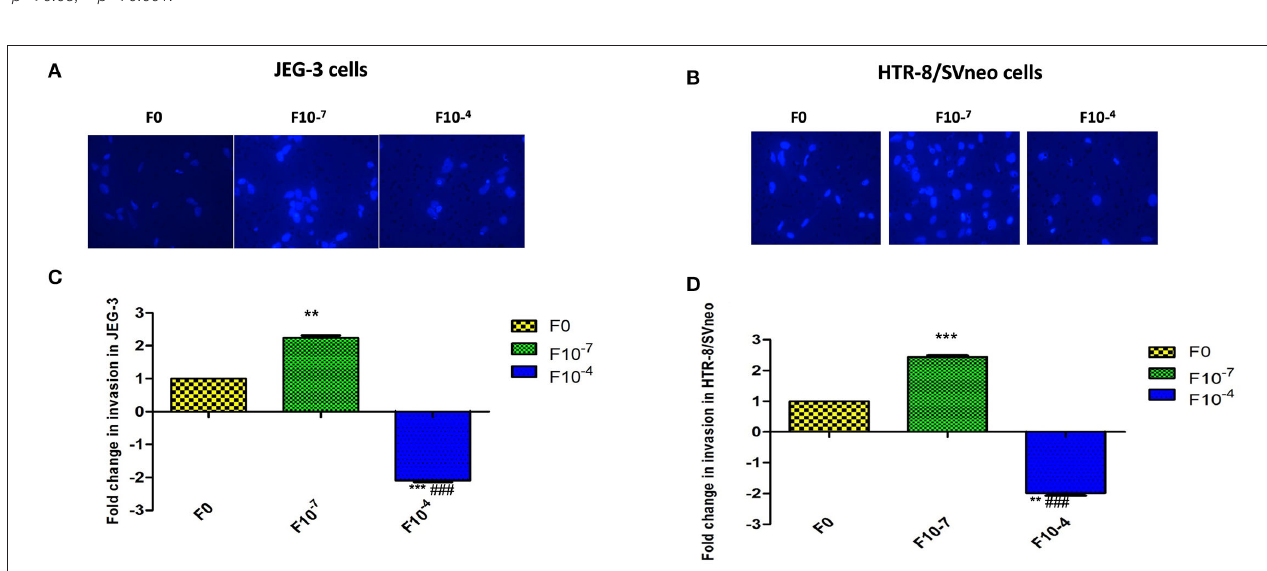
FIGURE 4 | Invasion assay in trophoblast cell lines supplemented with folic acid. (A, B) JEG-3 cells (A, C) Hoechest 33342 staining of invaded cells. (B, D) Fold change in invasion in JEG-3 and HTR-8/SVneo cells after 48h of treatment. F0-without folic acid supplementation, F10- 7 and F10- 4 folic acid supplementation at the concentration of 10- 7 and 10- 4 M, respectively. The data are expressed as mean ± SEM of three experiments. ** p < 0.01 and *** p < 0.001 with respect to the F0 control and ### p < 0.01 with respect to F10- 7 treated